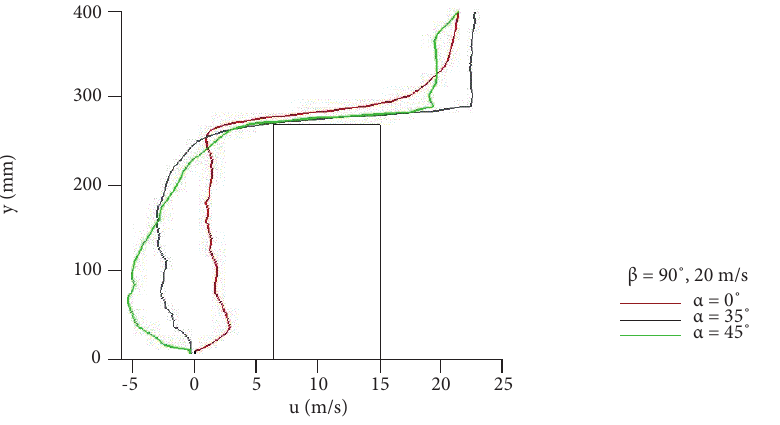
Figure 15. Velocity profi les in the MIT region for β = 90°.